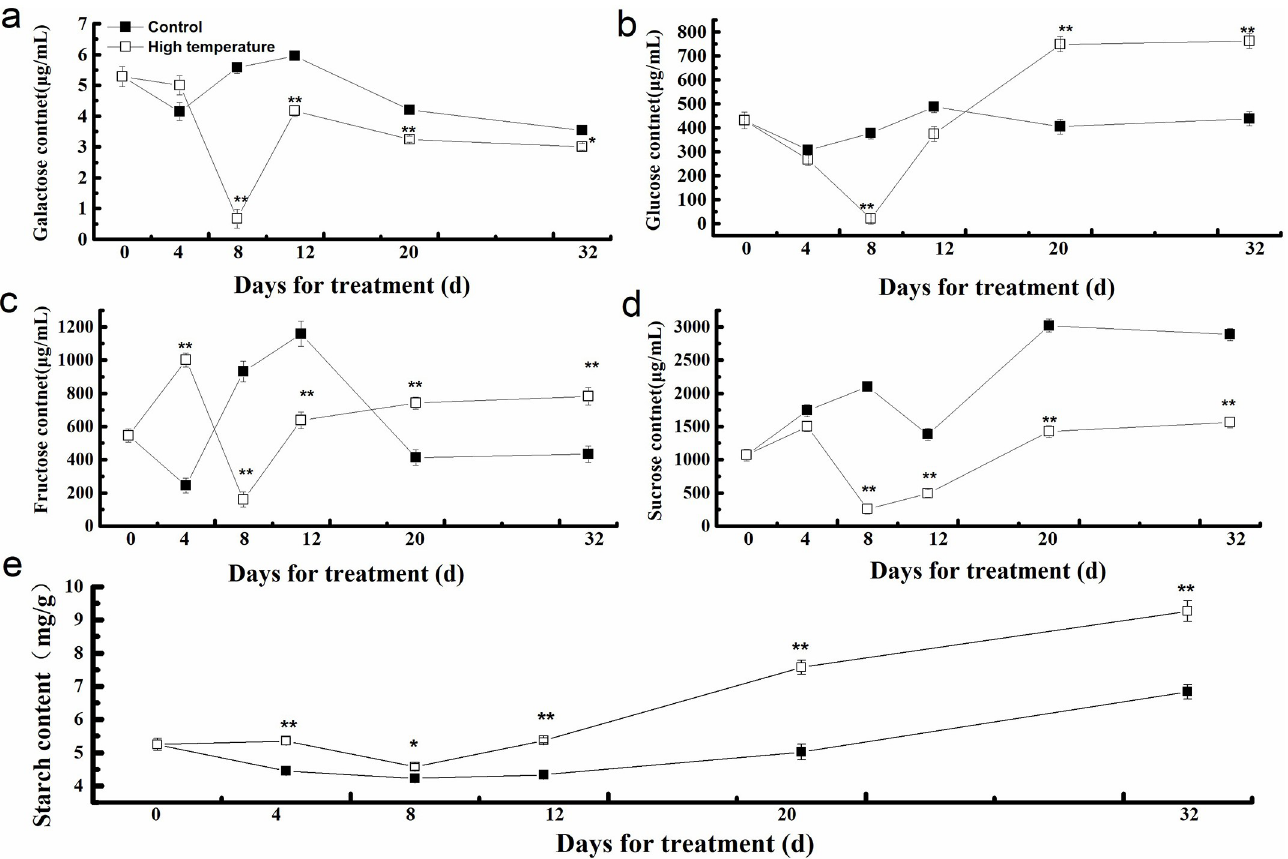
Fig 6. Changes in the contents of sugar components and starch in lettuce during bolting induced by high temperature. ( a ) Galactose content. ( b ) Glucose content. ( c ) Fructose content. ( d ) Sucrose content. ( e ) Starch content.